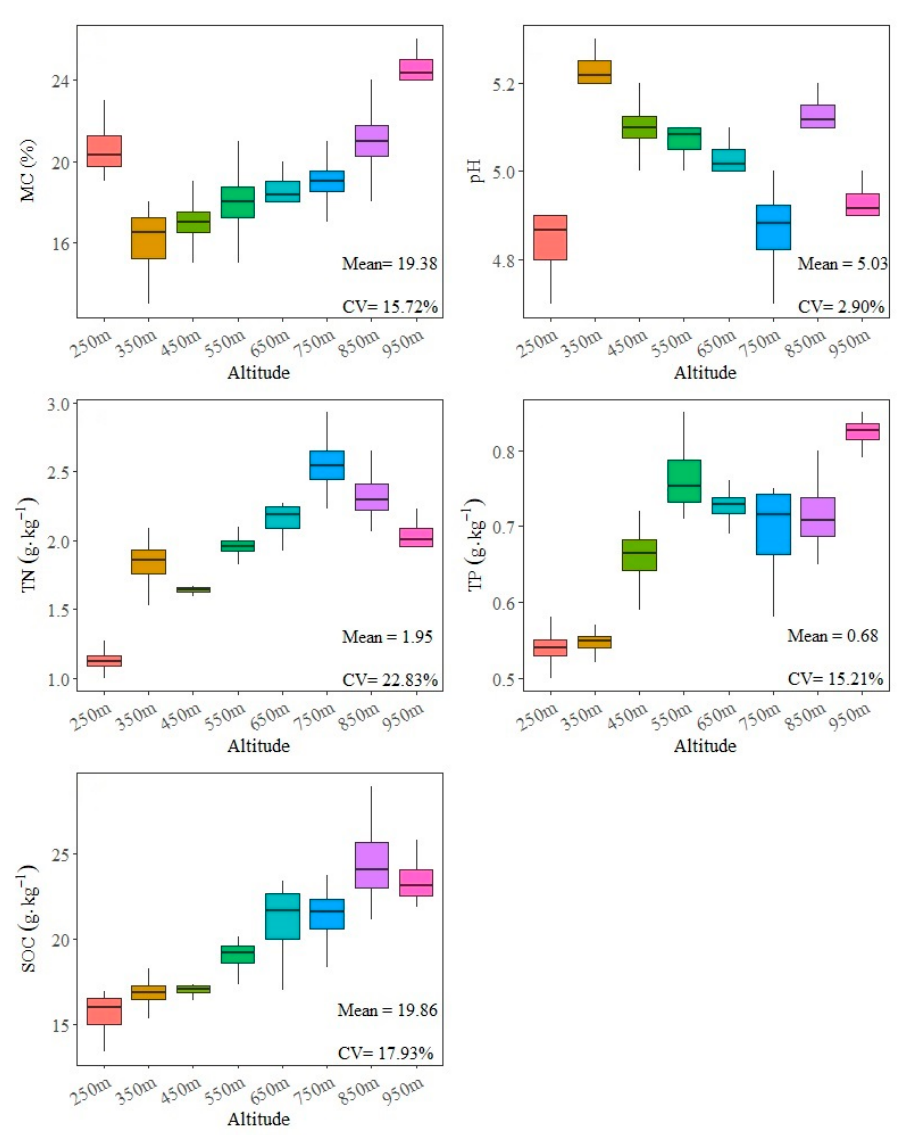
Figure 2. Soil physicochemical properties at di ff erent